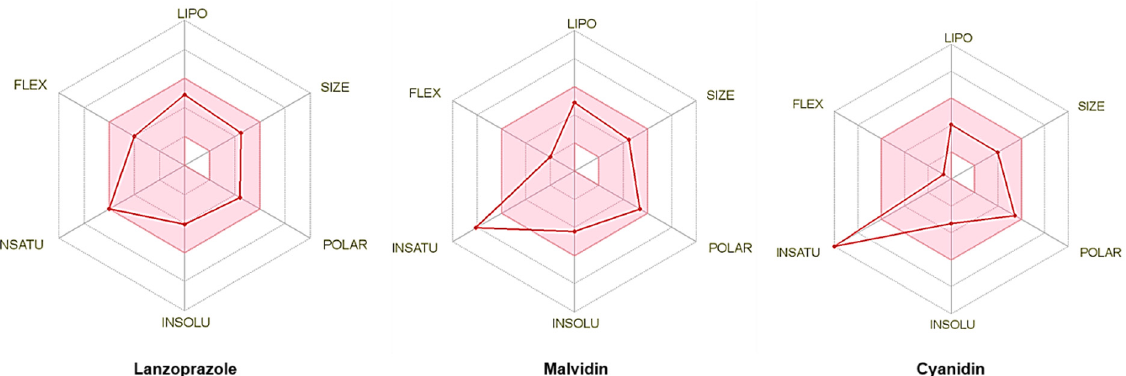
Figure 10. Oral bioavailability radar for the molecules lansoprazole, malvidin, and cyanidin. The colored area of the graph represents physicochemical space for optimum oral bioavailability. LIPO (lipophilicity): − 0.7 < XLOGP3 < +5.0; SIZE: 150 g/mol < MV < 500 g/mol; POLAR (polarity): 20 Å 2 < TPSA < 130 Å 2 ; INSOLU (insolubility): 0 < LOG S (ESOL) < 6; INSATU (establishment): 0.25 < CSP3 fraction < 1; FLEX (flexibility): 0 < number of rotatable connections < 9.